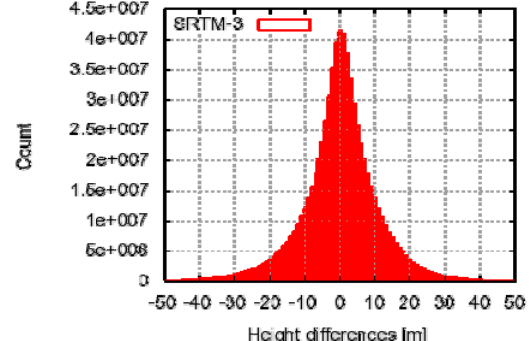
Figure 13. Histogram of height differences between PRISM DSM mosaic and SRTM-3.